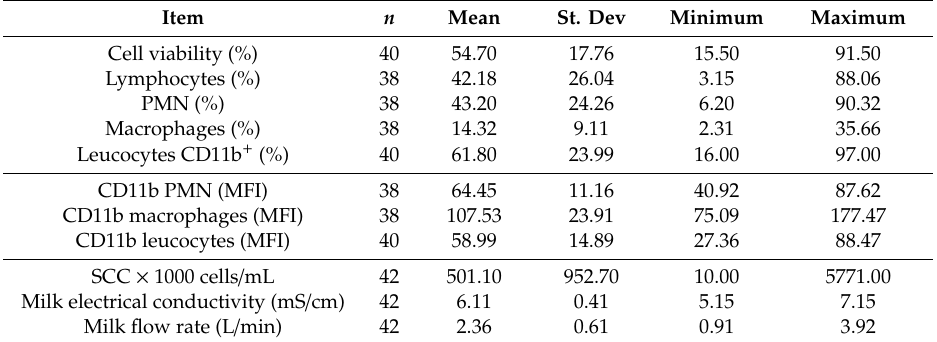
Table 1. Descriptive statistics of immunological traits and automated recorded farm parameters.